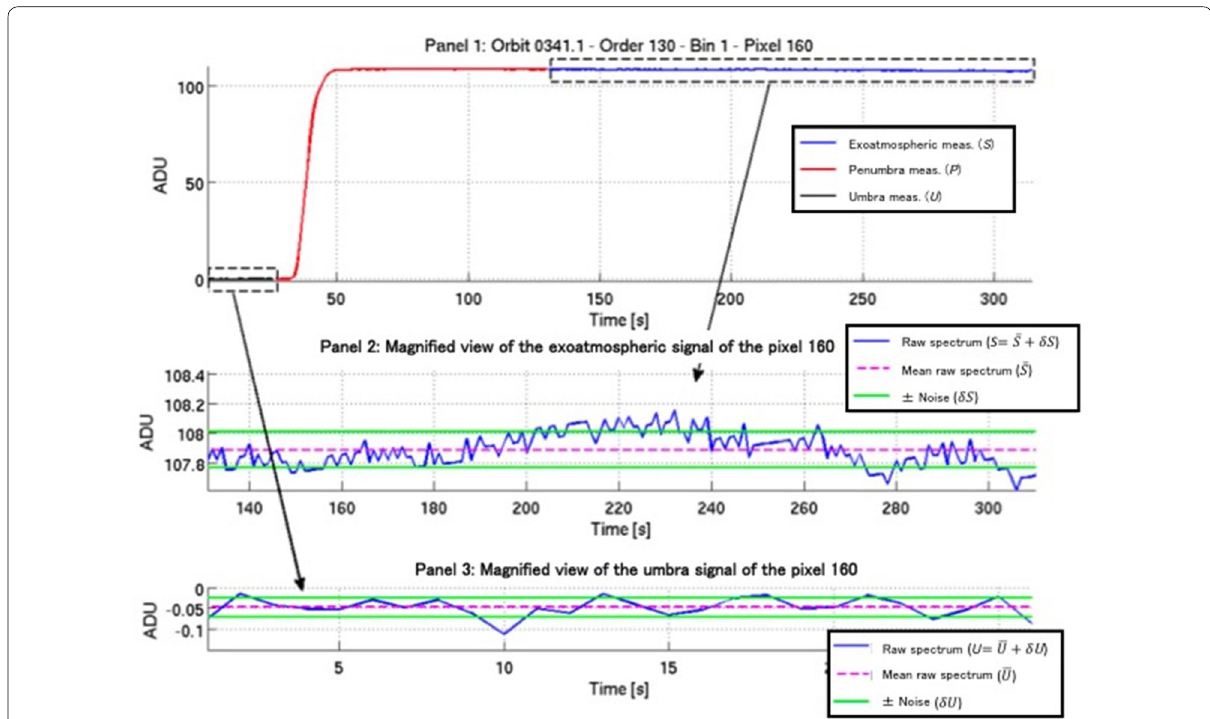
Fig. 8 Panel 1: Typical evolution through time of the signal (in ADU) on one pixel of the detector during a solar occultation. This example corresponds to an egress: at the beginning, no light reaches the detector when VEX is in the umbra region (black line); then, the occultation occurs when VEX is in the penumbra region (red line); finally, the instrument looks directly at the Sun and measures exoatmospheric raw spectra (blue line). The exoatmosphere and umbra zones used to derive the noise are indicated by the boxes. Panels 2 and 3: Variation of the noise signal around the mean value of the two zones (exoatmosphere in Panel 2 and umbra region in Panel 3). The standard deviations are shown by the lines in green (taken from A.C. Vandaele et al.